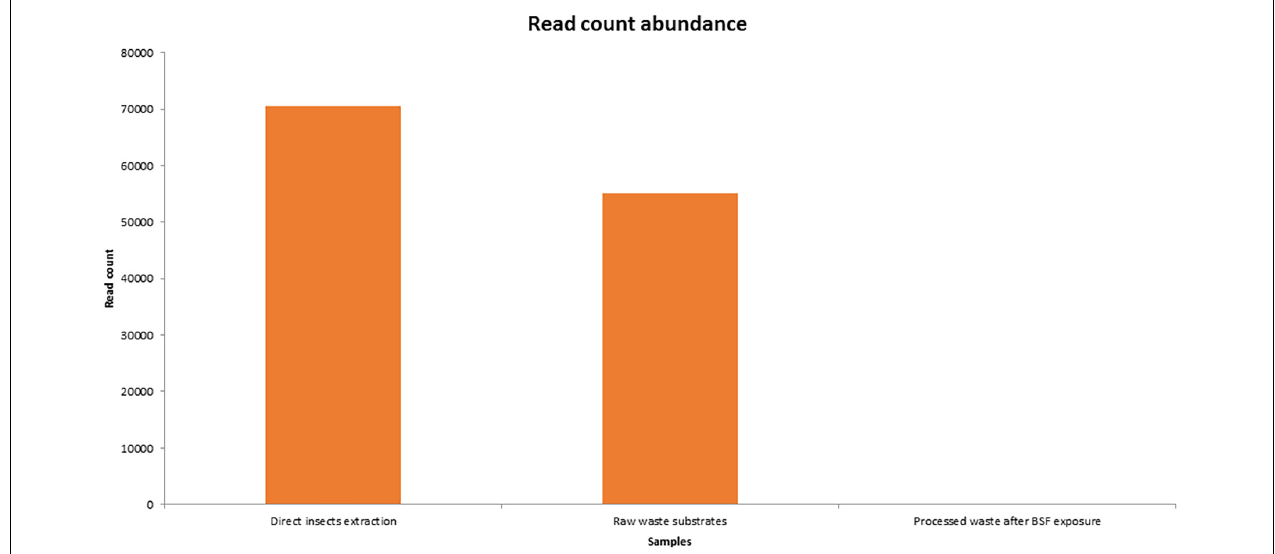
FIGURE 3 | Overview of 16S metagenomic library size generated by MinION sequencing of BSF and its substrates. There were three pooled sample categories i.e., direct insects extraction batch, raw waste substrates, and the processed waste substrates after BSF